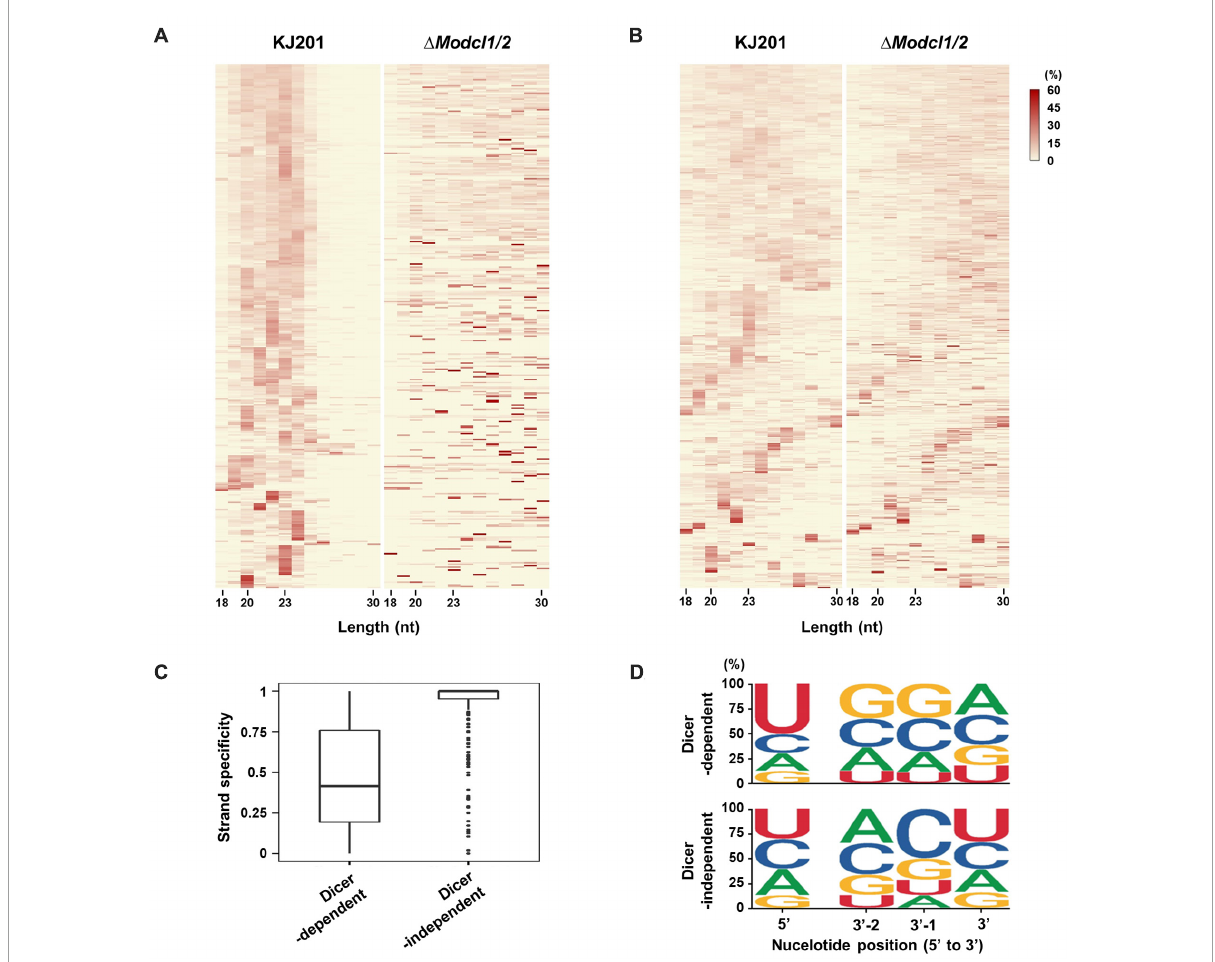
FIGURE4 sRNA features according to Dicer dependency. Size distributions of sRNAs from (A) Dicer-dependent sRNA loci and (B) Dicer-independent sRNA loci as heatmaps. (C) Strand-specificity of sRNAs from sRNA-producing loci. (D) Probability of nucleotide composition at the 5 (cid:48) -end position and three positions from the 3 (cid:48) -end, using sRNAs from Dicer-dependent and -independent sRNA loci. Nucleotide composition analysis at whole positions is shown in Supplementary Figure 5 .